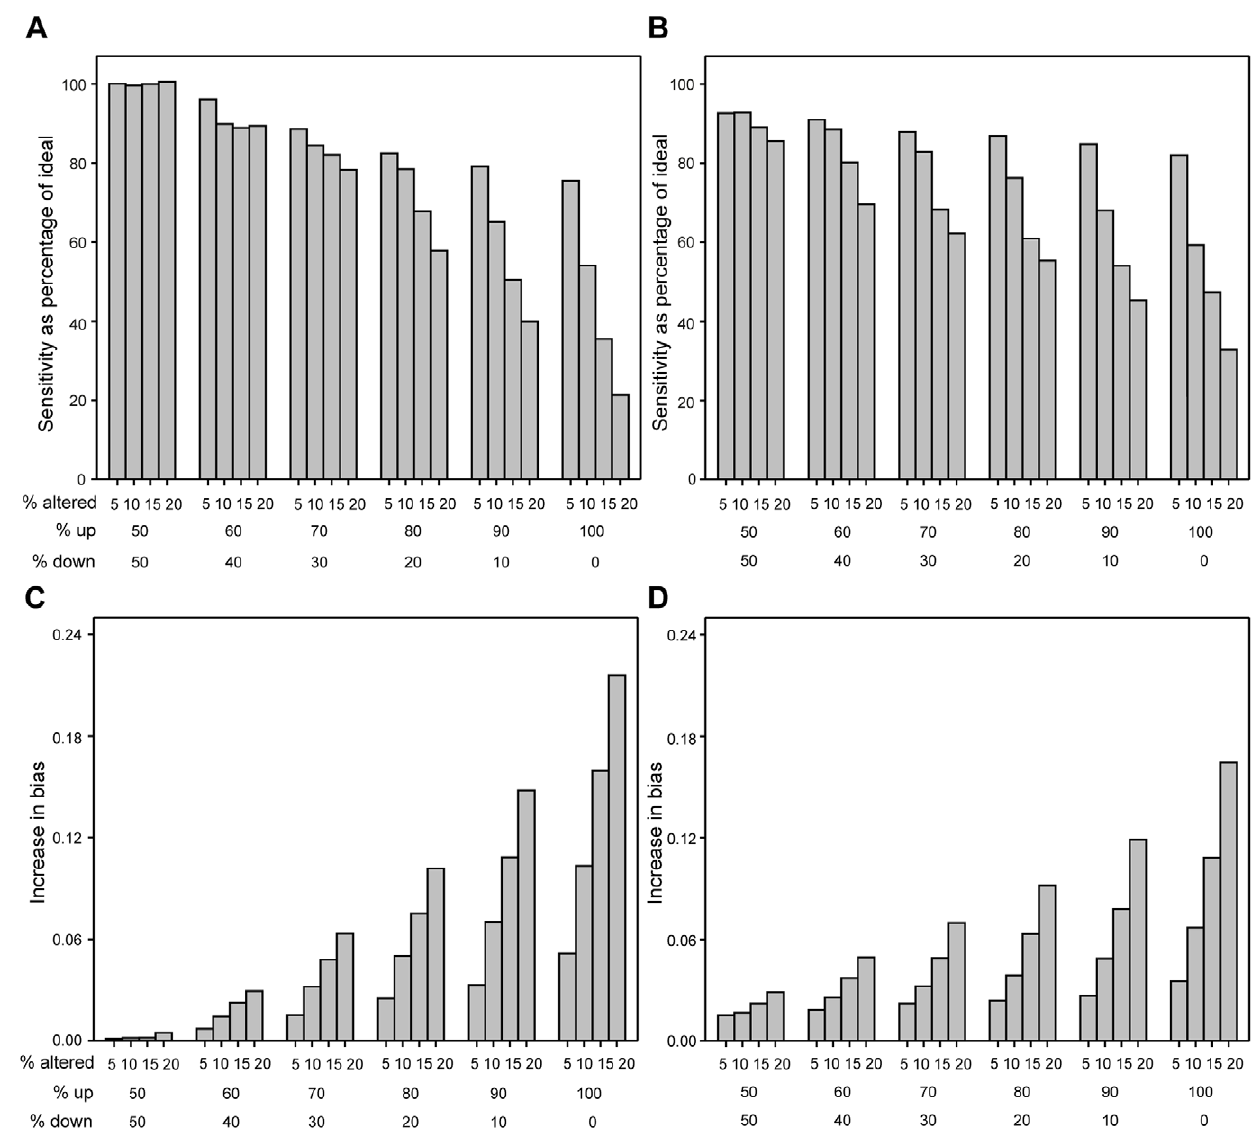
Figure 2. The effect of violating the primary assumptions. The sensitivity and bias for the standard quantile normalization and the rank invariant quantile normalization compared to the ideal quantile normalization ( i.e. a quantile normalization where only the non-regulated clones influenced the normalization) for different percentages of altered clones (% altered) and different distributions of up- and down-regulated clones. (A) The relative sensitivity of the standard quantile normalization observed at 0.5% false positive rate ( i.e. the ratio between the sensitivity observed when the standard and ideal quantile normalization was applied to the data). (B) The relative sensitivity of the invariant quantile normalization at 0.5% false positive rate. (C) The difference in bias between the standard and ideal quantile normalization (D). The difference in bias between the invariant and ideal quantile normalization.